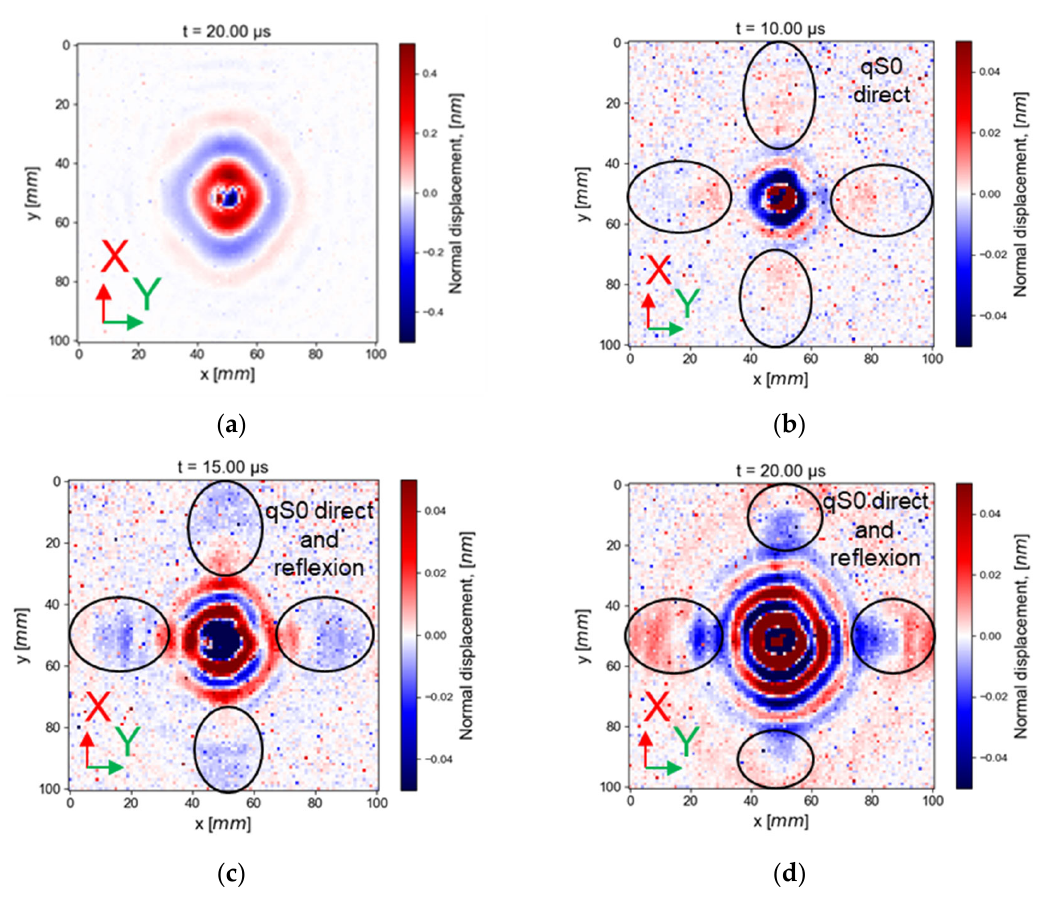
Figure 12. Wave generation with an embedded transducer in the cut-out at ( a ) 50 kHz and at ( b – d ) 150 kHz at 10, 15, and 20 µ s (first edge reflections for qS0: 17 µ s visible at 25 mm from the PZT center).